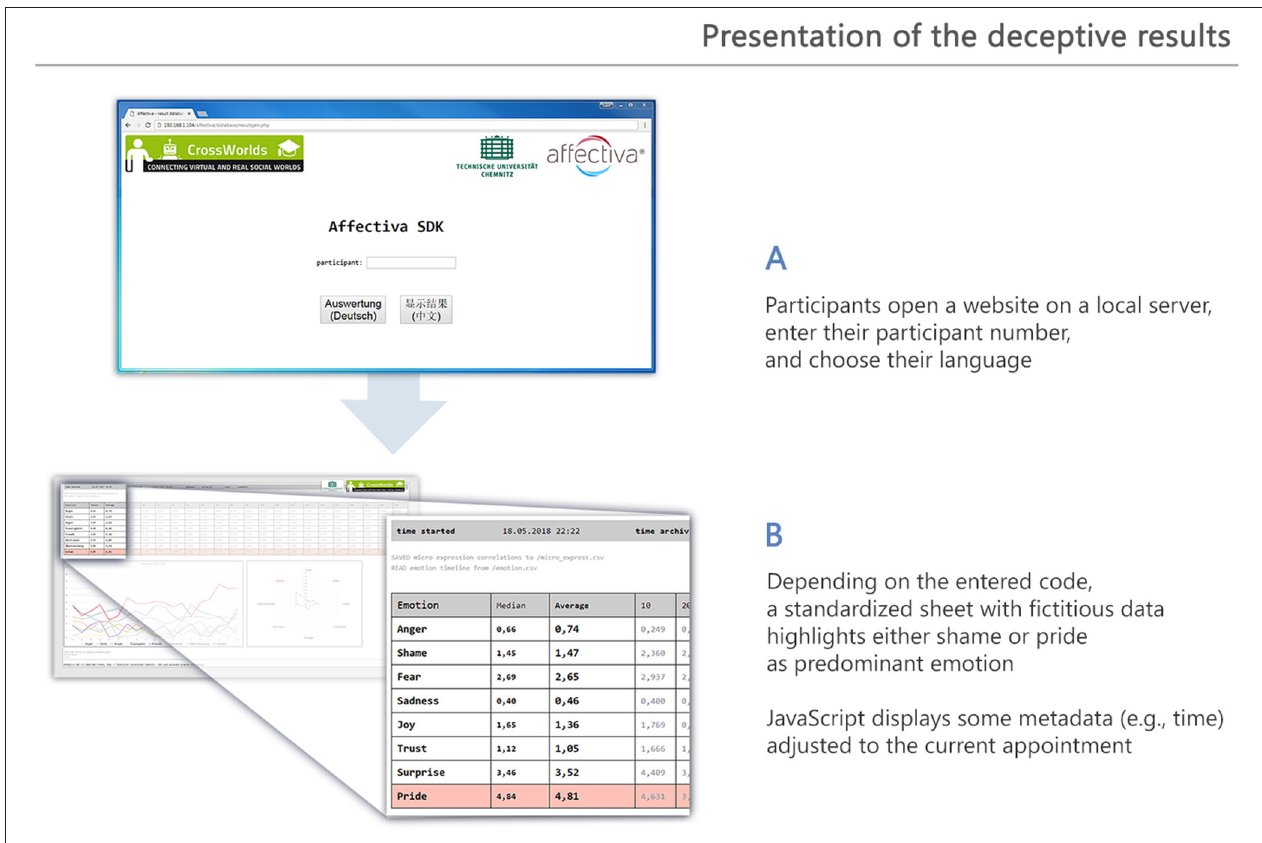
FIGURE 3 | Procedure to convey the deceptive result sheet after the experimental task. (A) The login screen hosted on a local web server. (B) Result sheet with fictitious data. The allegedly most prevalent emotion is displayed in red—either shame or pride, depending on